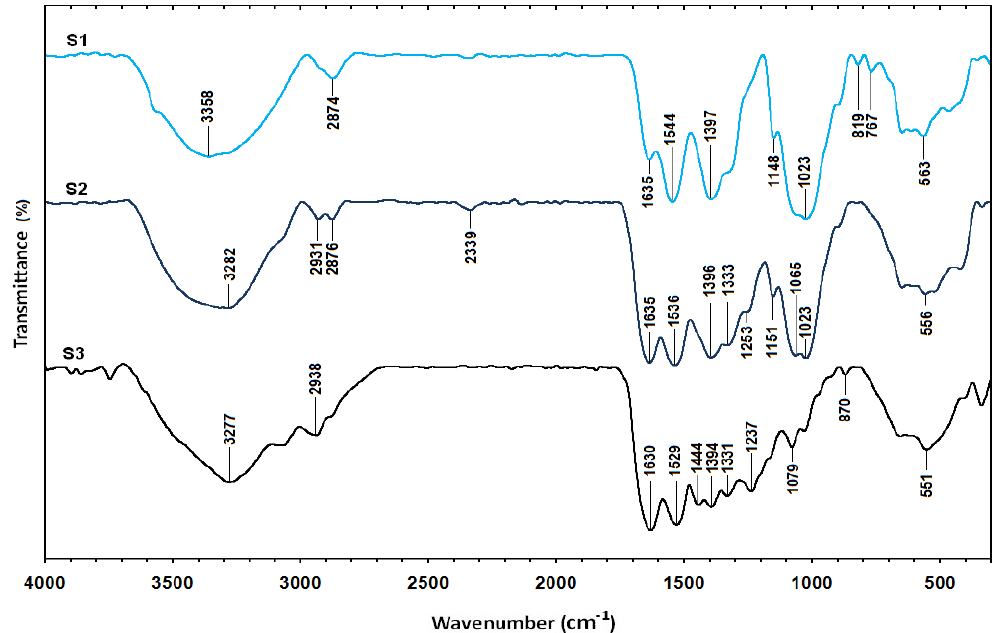
Figure 7. Fourier transform infrared spectra for the Ag/Cts (S1), Ag/Cts/gelatin (S2) and Ag/gelatin